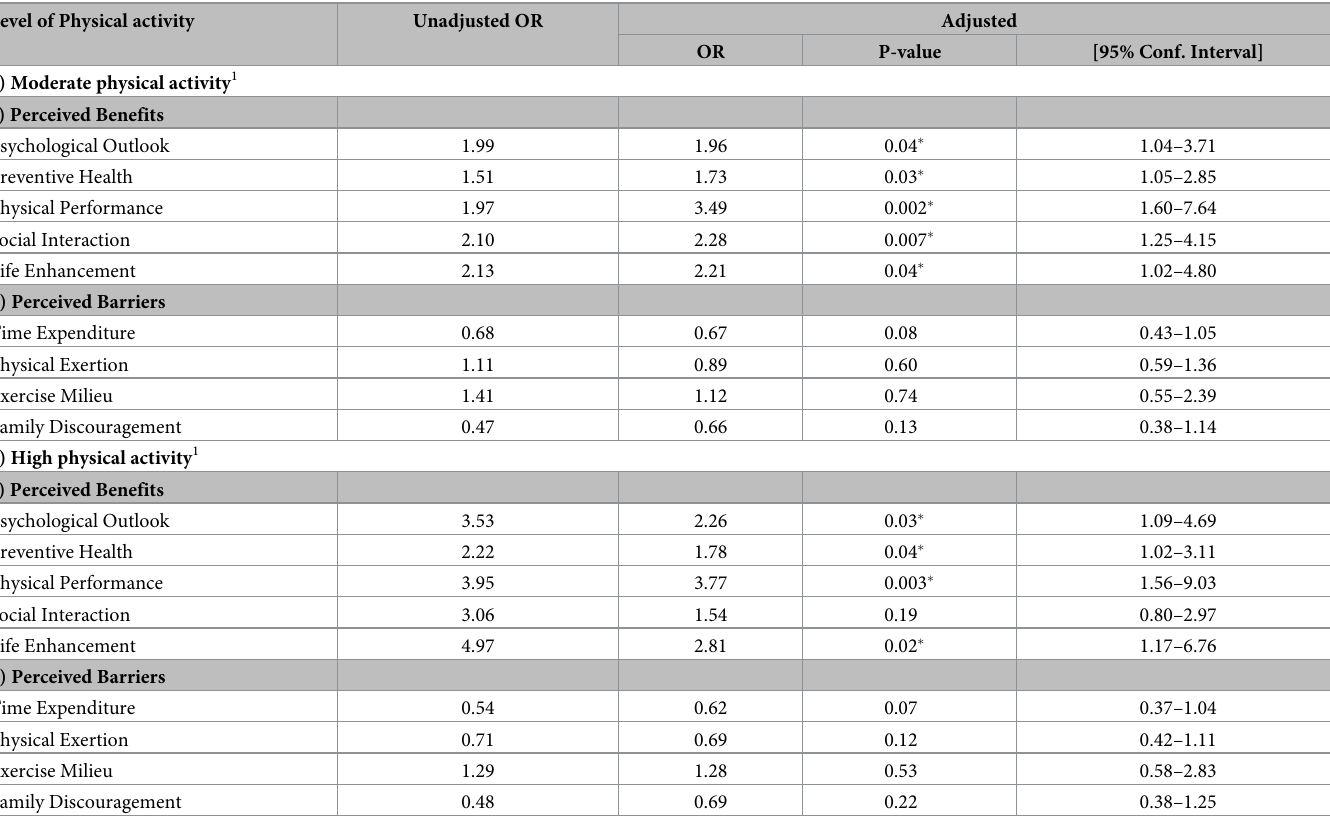
Table 7. Multinomial logistic regression analysis of barriers and facilitators of physical activity among urban diabetic patients in Nepal (n =